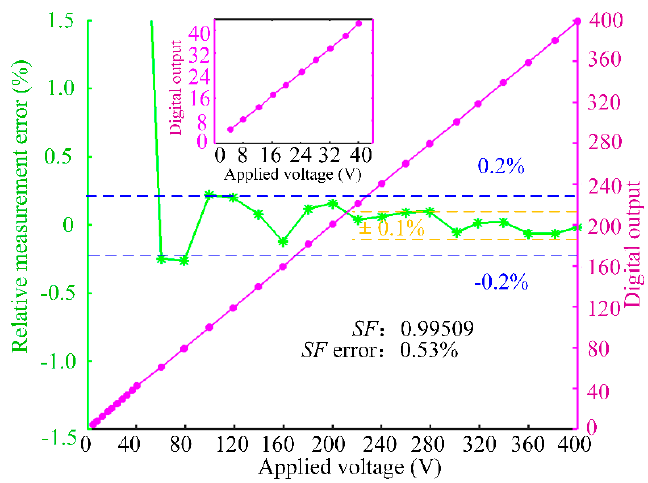
Figure 8. The detection accuracy of OVS with low voltage applied .